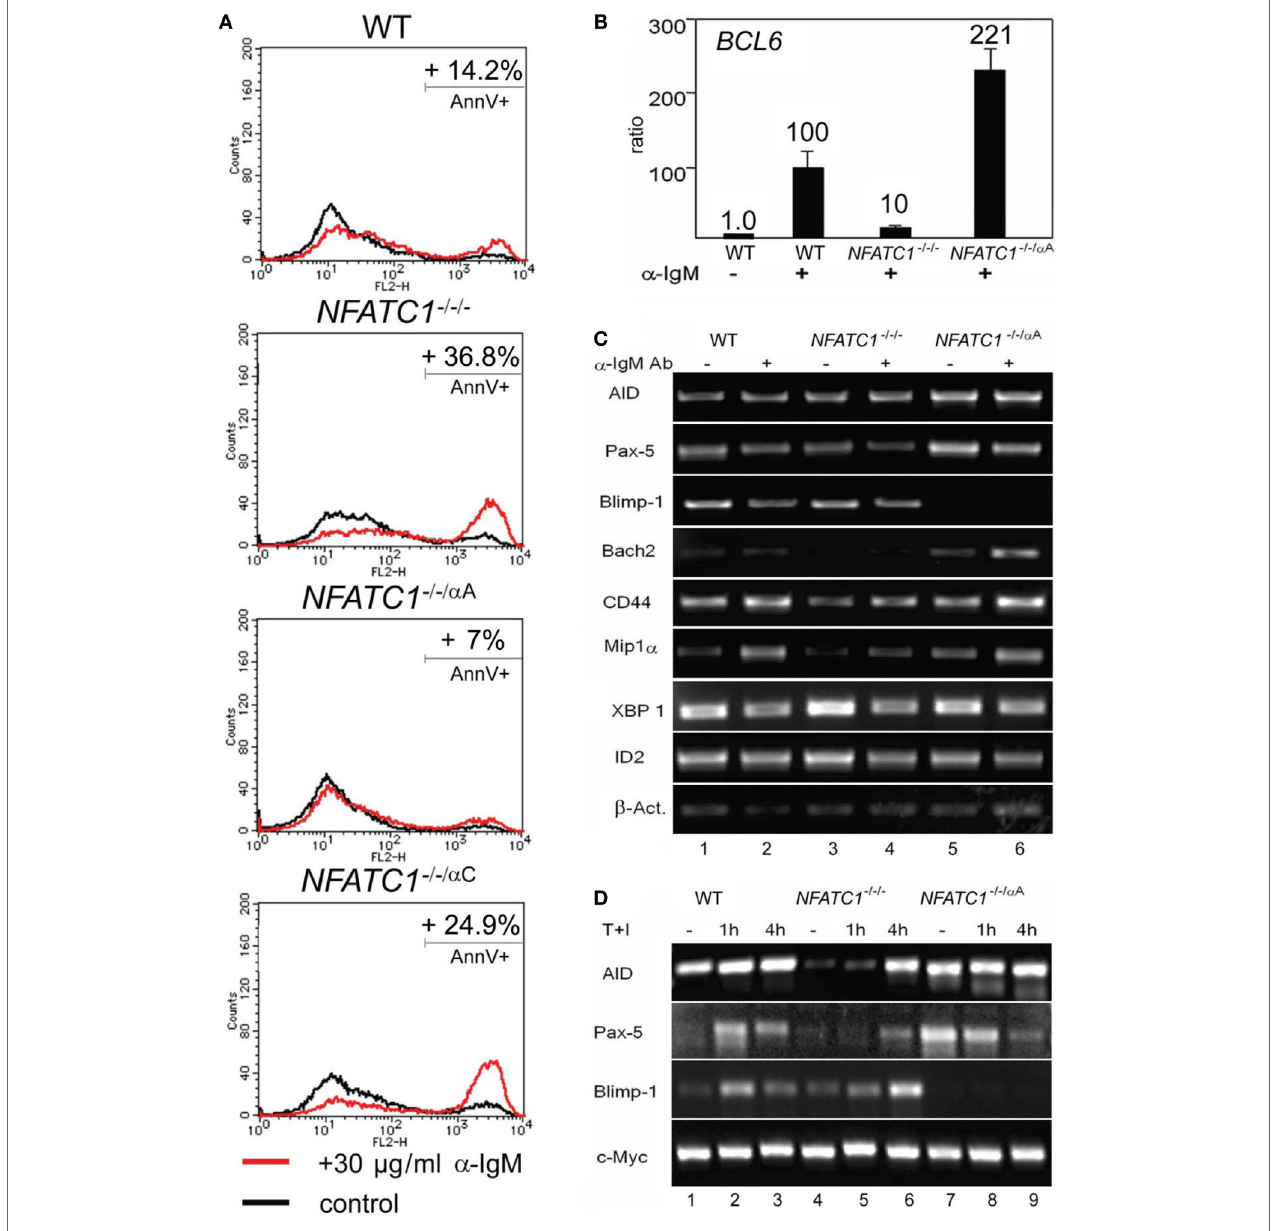
FigUre 2 | NFATc1/ α A suppresses cell death and Prdm1/ Blimp-1 expression in chicken DT40 B cells. (a) WT, NFATC1 − / − / − , NFATC1 − / − / α A , and NFATC1 − / − / α C DT40 cells were stimulated with 30 µg/ml α -IgM M4 Ab for 28 h. Cells were stained by annexin V-Cy3. Shown is the percentage of apoptotic cells in one typical experiment from more than three. (B) Real-time qPCR assays. RNAs were isolated from either untreated DT40 B cells—or from cells treated with 30 µg/ml α IgM for 6 h ( + ) using a QIAamp RNA Blood kit (QIAGEN), and quantitative RT-PCR assays were performed using TaqMan probes for detecting Bcl-6 and GAPDH3 RNAs as internal control. (c,D) Human NFATc1/ α A affects the gene signature of DT40 cells. RNAs from untreated DT40 B cells—or from cells treated with α -IgM for 4